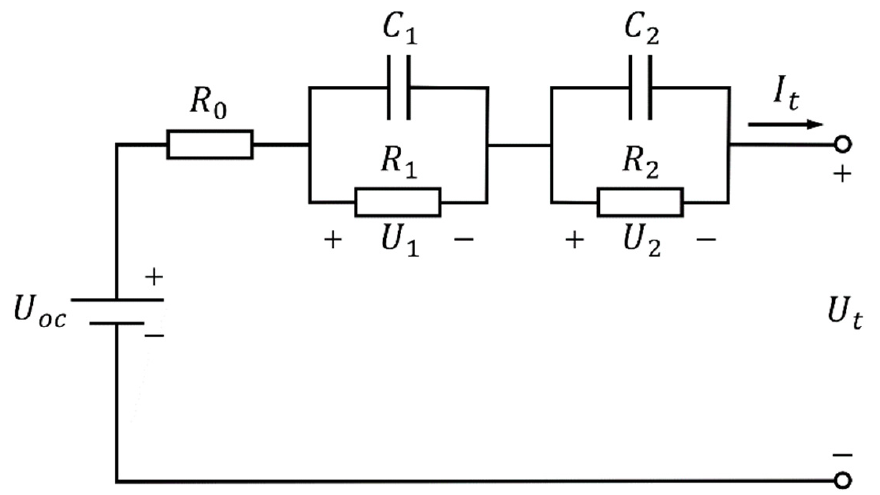
Figure 1. Second-order equivalent circuit diagram of lithium-ion battery. where U oc is the battery’s open-circuit voltage; U 1 is the battery’s electrochemical polarization voltage; U 2 is the battery’s concentration polarization voltage; U t is the terminal voltage of the battery; I t is the operating current of the battery; R 0 is the battery’s ohmic resistance; R 1 and C 1 are the battery’s electrochemical reaction inside the battery; and R 2 and C 2 are the battery’s concentration polarization resistance